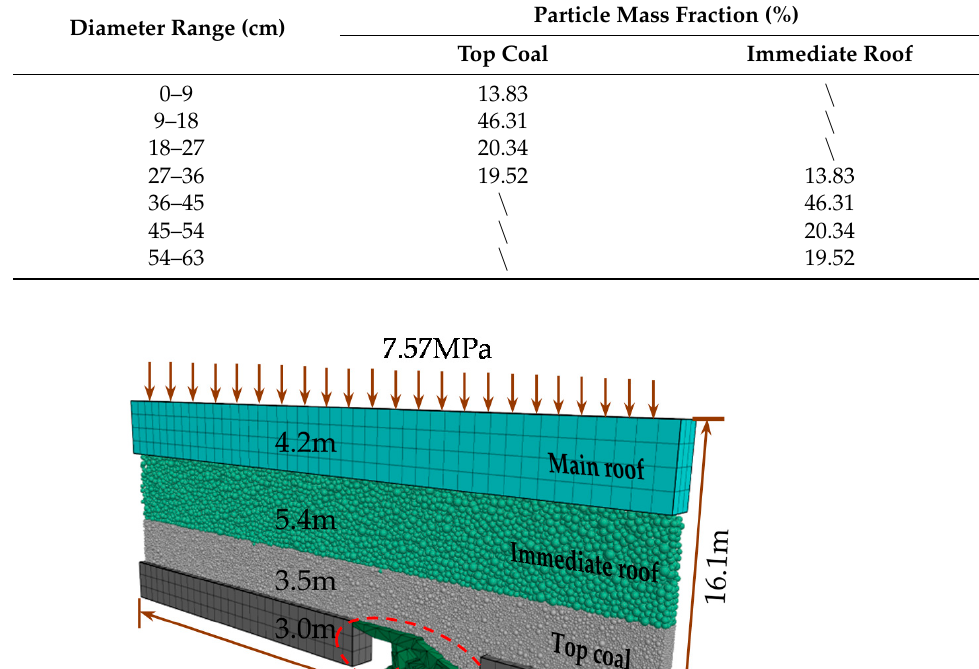
Table 2. Particle mass fraction [31].